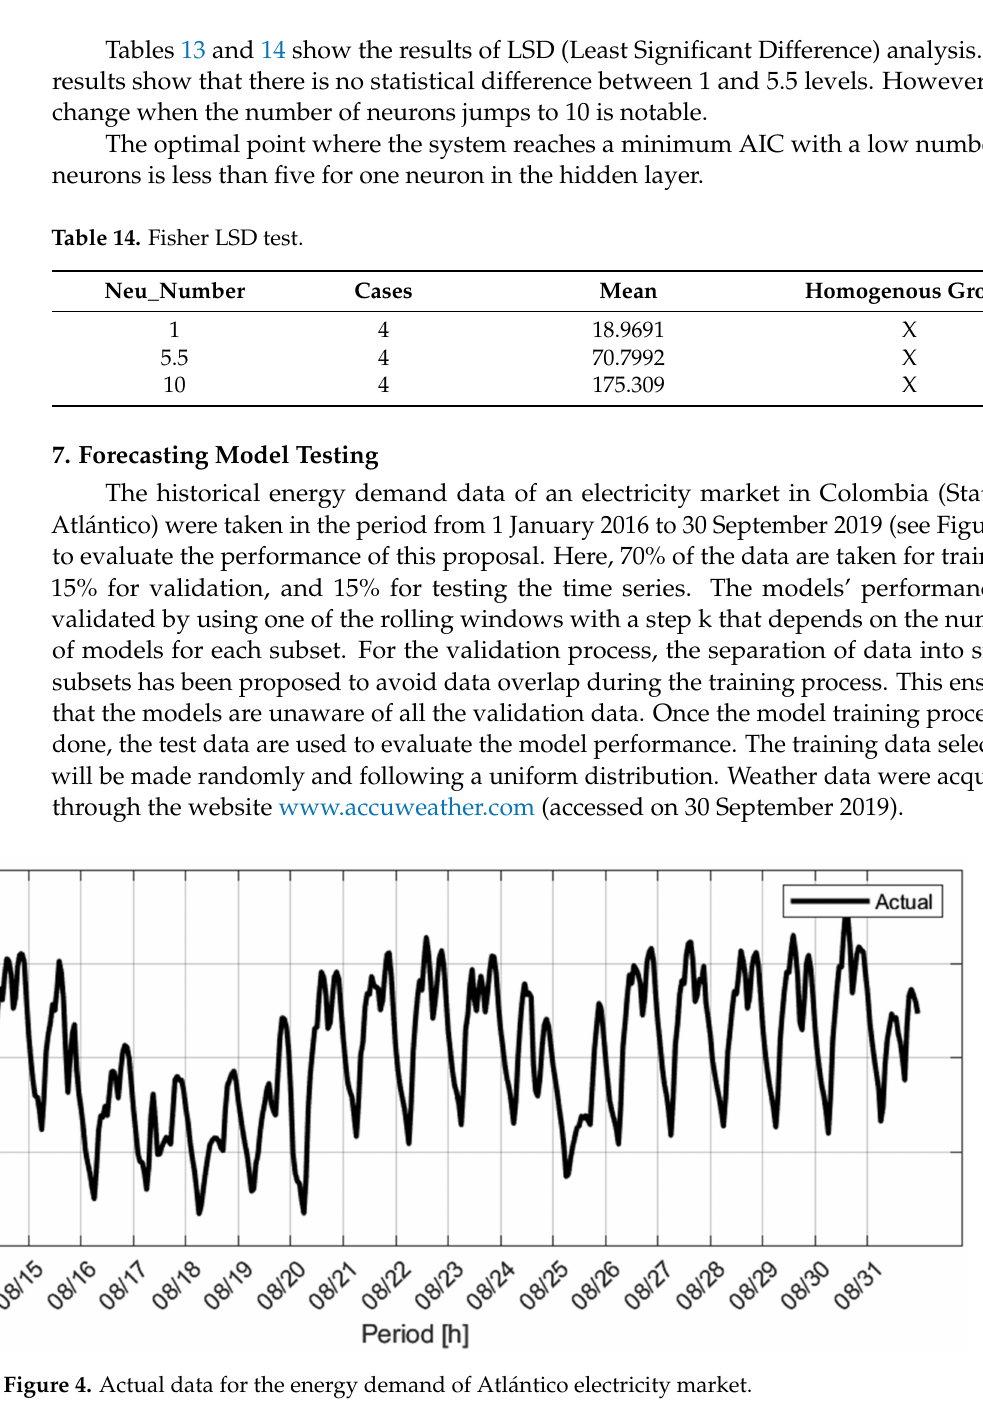
Figure 4. Actual data for the energy demand of Atl á ntico electricity